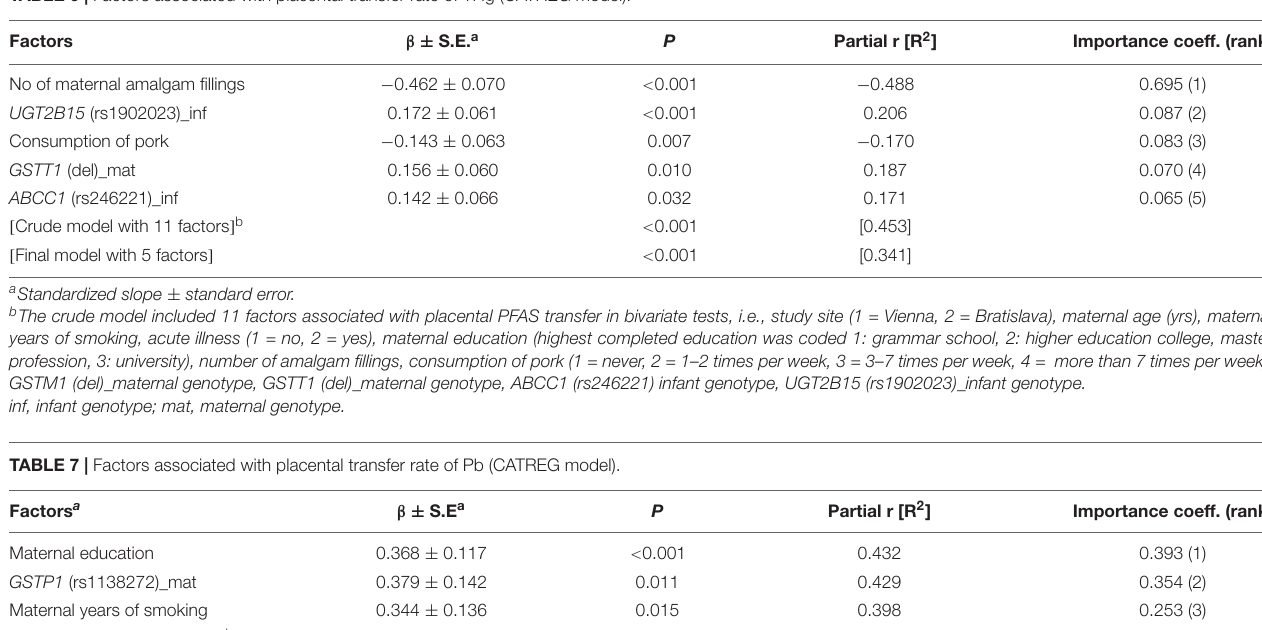
TABLE 6 | Factors associated with placental transfer rate of THg (CATREG model).